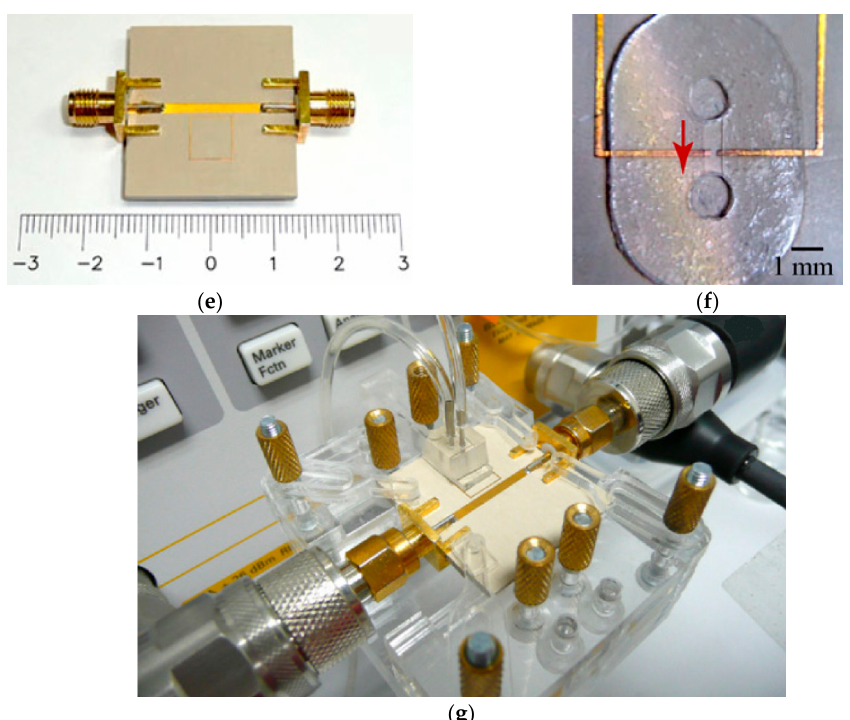
Figure 2. ( a ) Microstrip-coupled SRR etched on the top of a substrate. ( b ) Equivalent circuit of the proposed resonator with Lm represents the inductance of microstrip line, {RLC}s for the parasitic elements of the ring resonator, and M for the mutual inductance between SRR and microstrip line. ( c ) Simulated transmission magnitude of the proposed resonator, and in inset electric field magnitude at 2.1 GHz (resonant frequency) with the highest electric field at the split-gap of ring resonator. ( d ) Measured transmission magnitude showing various profiles of the proposed chemical sensor, 100% ethanol being the lossy chemical showing the lowest Q factor as compared to air and water. ( e ) Fabricated prototype assembled with two SMA (SubMiniature version A) connectors. ( f ) A zoom-in view showing the microfluidic channel accurately positioned on the SRR gap. The red arrow indicates the direction of fluidic flow. ( g ) Fully assembled sensor with polymer tubes delivering liquid into the chamber and coaxial cables connected to the vector network analyzer (Redrawn from [33]). A microstrip coupled CSRR has been proposed as a chemical sensor [34]. The microstrip line is designed on the top of substrate and CSRR is etched on the bottom ground. The concentration of water-ethanol solution was varied, and corresponding S-parameters were measured. To validate the proposed sensing system, the measured complex permittivity values of mixture were compared with the reference ones. This sensor showed four times higher sensitivity as compared to their previous work, as already described in [33].